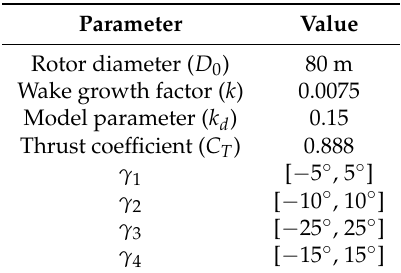
Figure 13. Schematic for 5 turbine wind farm layout in non-yawed and yawed condition. Table 2 highlights various parameters and their values used to compute effective velocity deficit with yaw angle γ j for j ∈ [ 1, 2, 3, 4 ] . Table 2. Wind turbine Parameters for WT 4 and WT 5